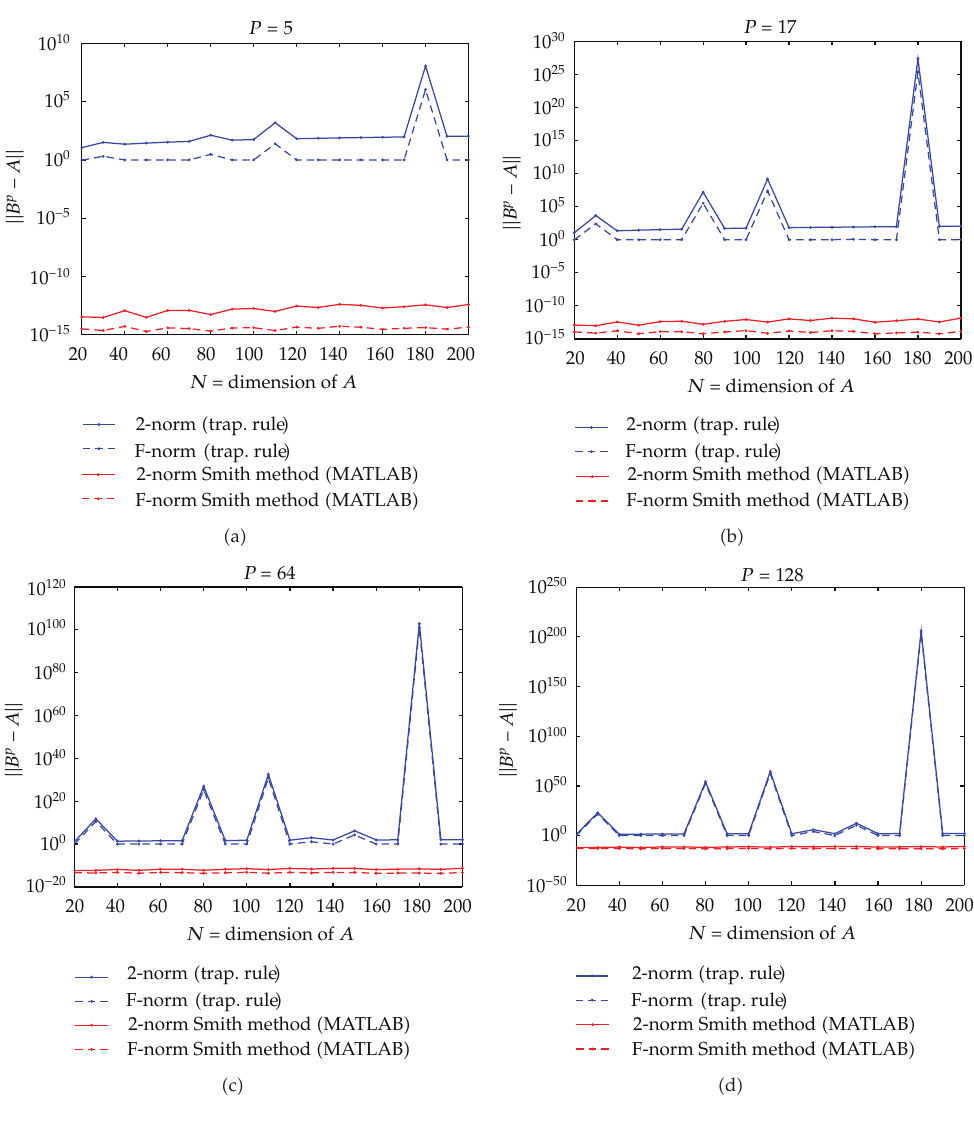
Figure 6: Residual error for computing A 1 /p for Lehmer matrix.